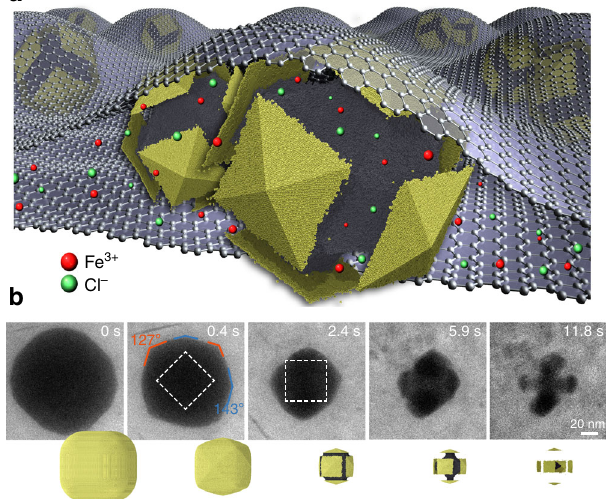
Fig. 2 Real-time imaging of rapid dissolution of a Pd@Au nanocube inside a GLC. a Schematic illustration of a GLC encapsulating a solution of nanocubes and oxidative etchants. Carbon atoms of graphene sheets are enlarged for clarity purpose. b Time-lapse TEM images and corresponding simulation snapshots extracted from Supplementary Movies 1a and 4 showing the dissolution of nanocubes (44-nm Pd core and 35-nm Au shell) under strongly oxidative environment. Chemical potential in simulation: − 3.600